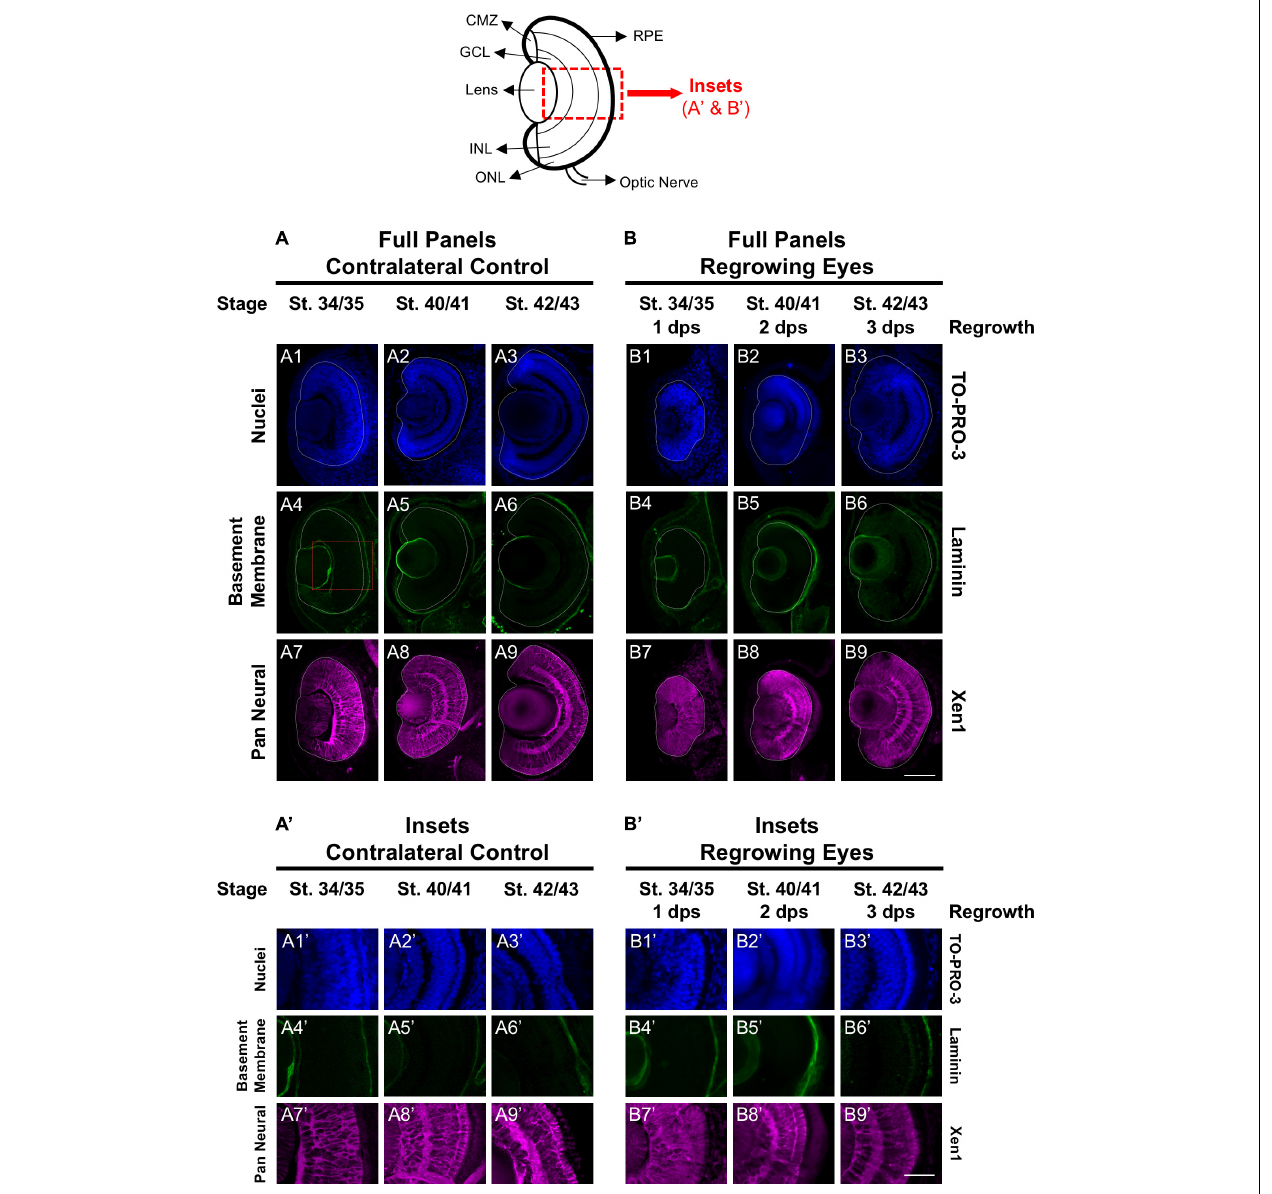
FIGURE 1 | Regrown eyes regain cellular patterning by 3 dps. Images shown are immunostained, transverse sections at three developmental timepoints corresponding to 1, 2, and 3 days post surgery (dps). The top schematic is a diagram of a section through a mature, differentiated tadpole eye. (A,B) Regrowing eyes display retinal patterning comparable to the contralateral control eyes (unoperated) by 3 days. White dashed lines delineate each eye. (A’,B’) Representative images shown in panels A’ and B’ correspond to the region shown in the inset box in panel A4 for the corresponding A or B panel at high magnification. Blue color indicates nuclear staining (TO-PRO-3). Green color indicates the basal lamina (anti-Laminin), which is expressed in all basement membranes and outlines the optic vesicle. Magenta color indicates neural tissues (Xen1). Sample sizes: 1 day, n = 6; 2 days, n = 5; and 3 days, n = 5. (A,B, A’,B’) Up = dorsal, down = ventral, lens is on the left. Scale bar: A,B = 100 µ m and A’,B’ = 50 µ